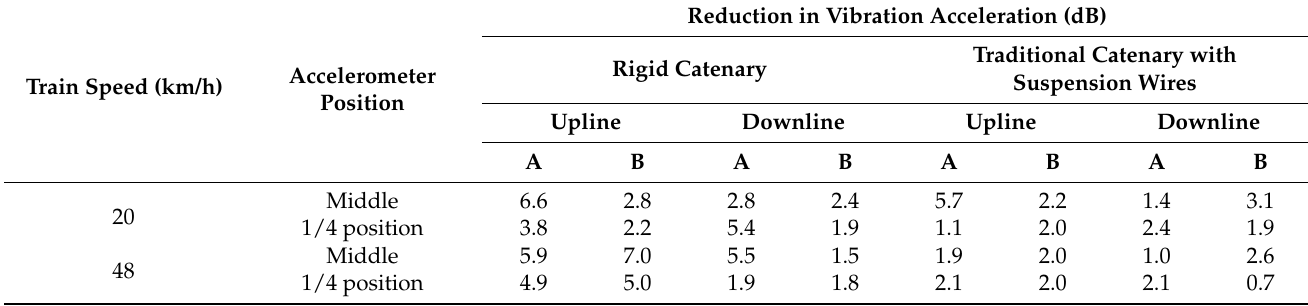
Table 8. Reduction in vibration acceleration of pantograph strips.